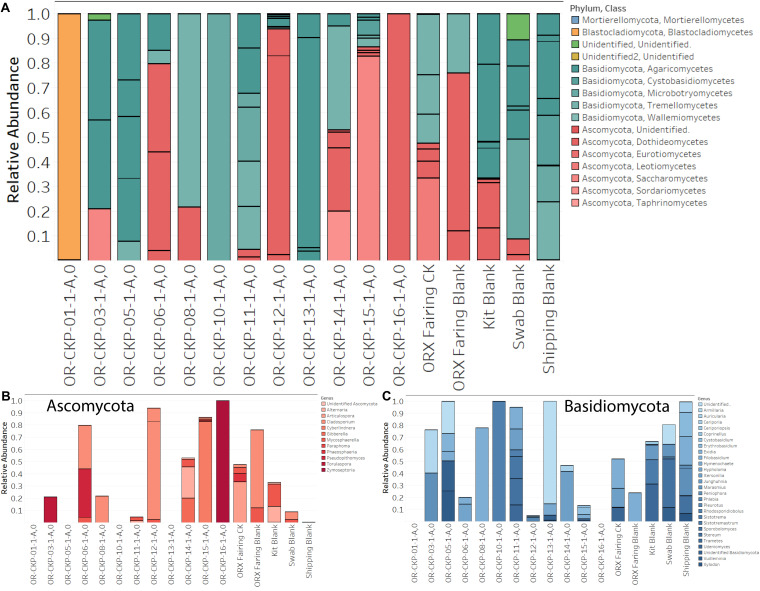
Fungal sOTUs identified in each sample (A). sOTUs are colored by pyhlum and class. Most samples are dominated by sequences belonging to Basidomycota (blue bars; A,C). Samples 6, 12, 15, and 16 are dominated by Ascomycota (red bars; A,B). Abundant phyla are plotted at the genus level in (B,C).